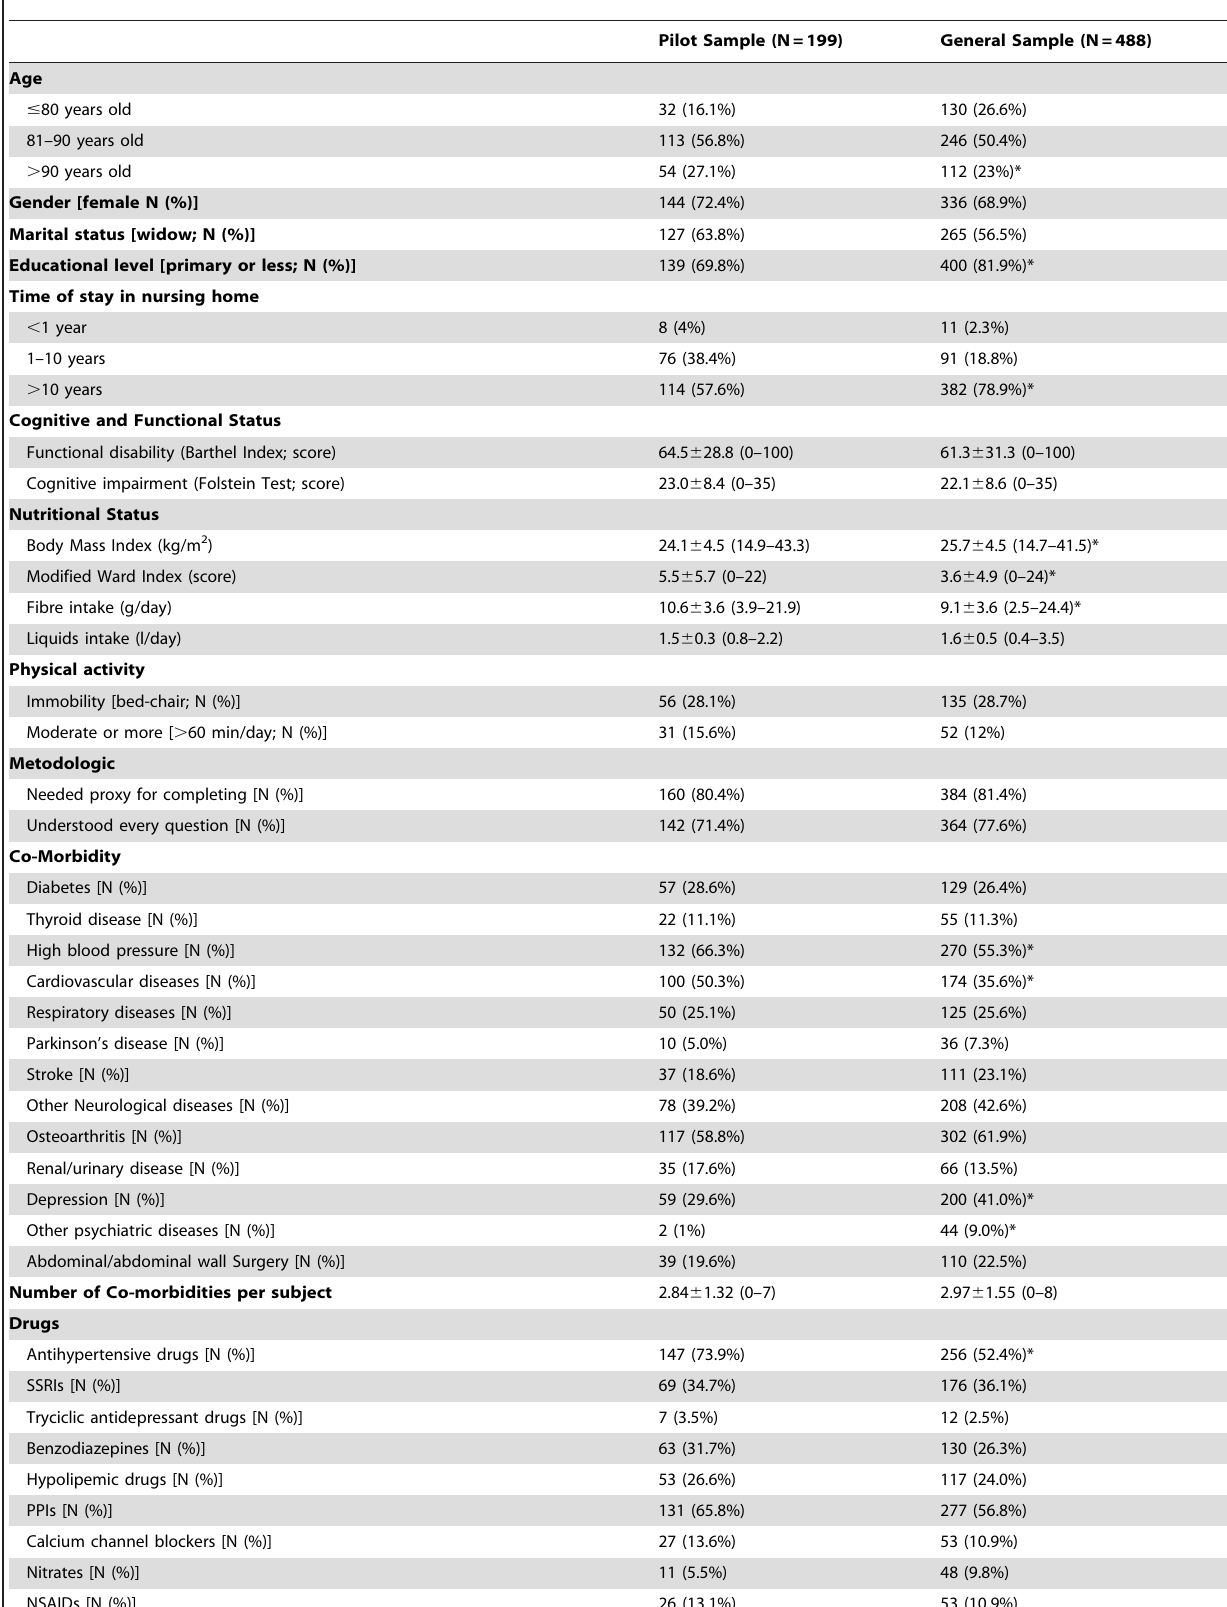
Table 1. Comparison between the pilot sample and the general